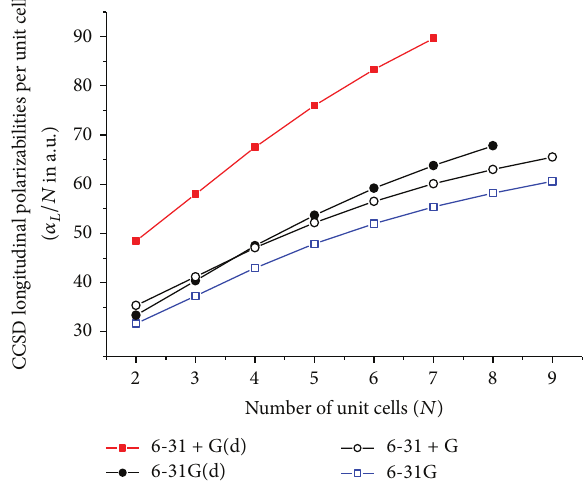
Figure 2: Longitudinal polarizabilities per unit cell (𝛼 𝐿 /𝑁) of polyenes (in a.u.) obtained by CCSD with various basis